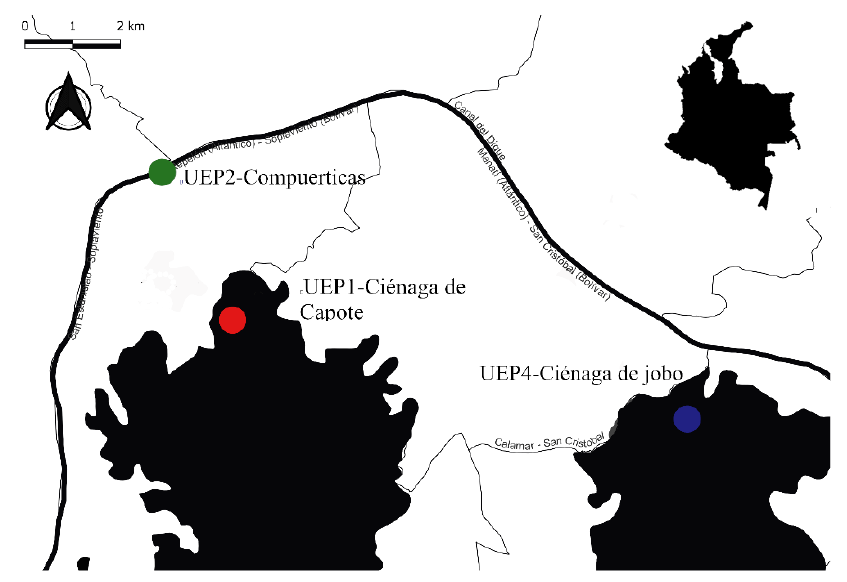
Figure 1. Location of Sampling Points. Zodes Dique (Canal del Dique Subregion: Red: UEP1, Green; UEP2; Blue: UEP4. Source: Author).